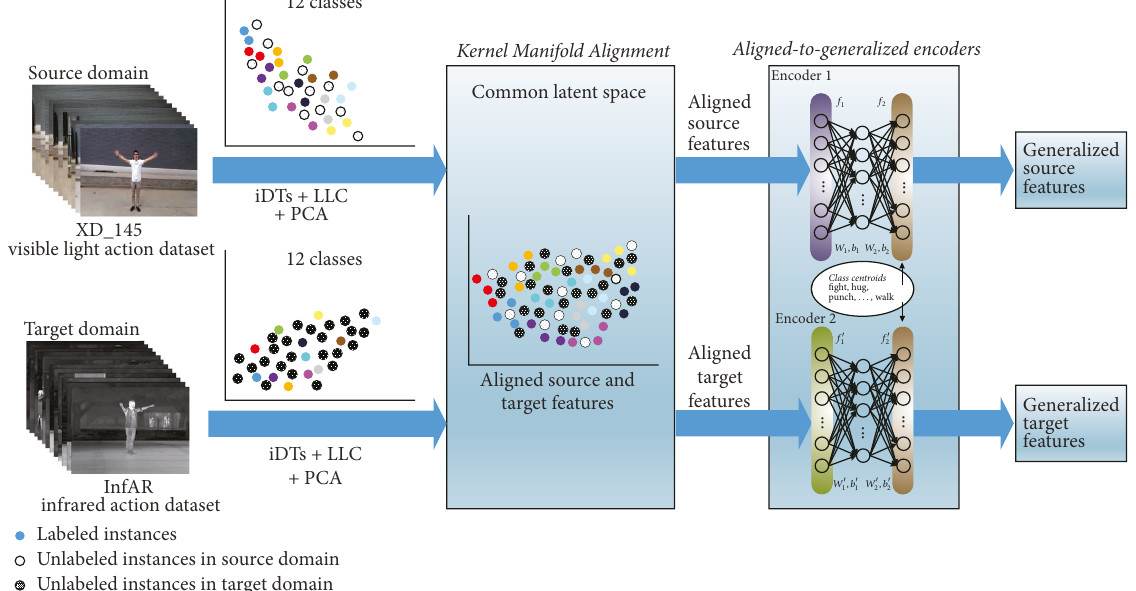
Figure 3: Illustration of aligned-to-generalized encoders generalizing aligned features across visible light and infrared action datasets.